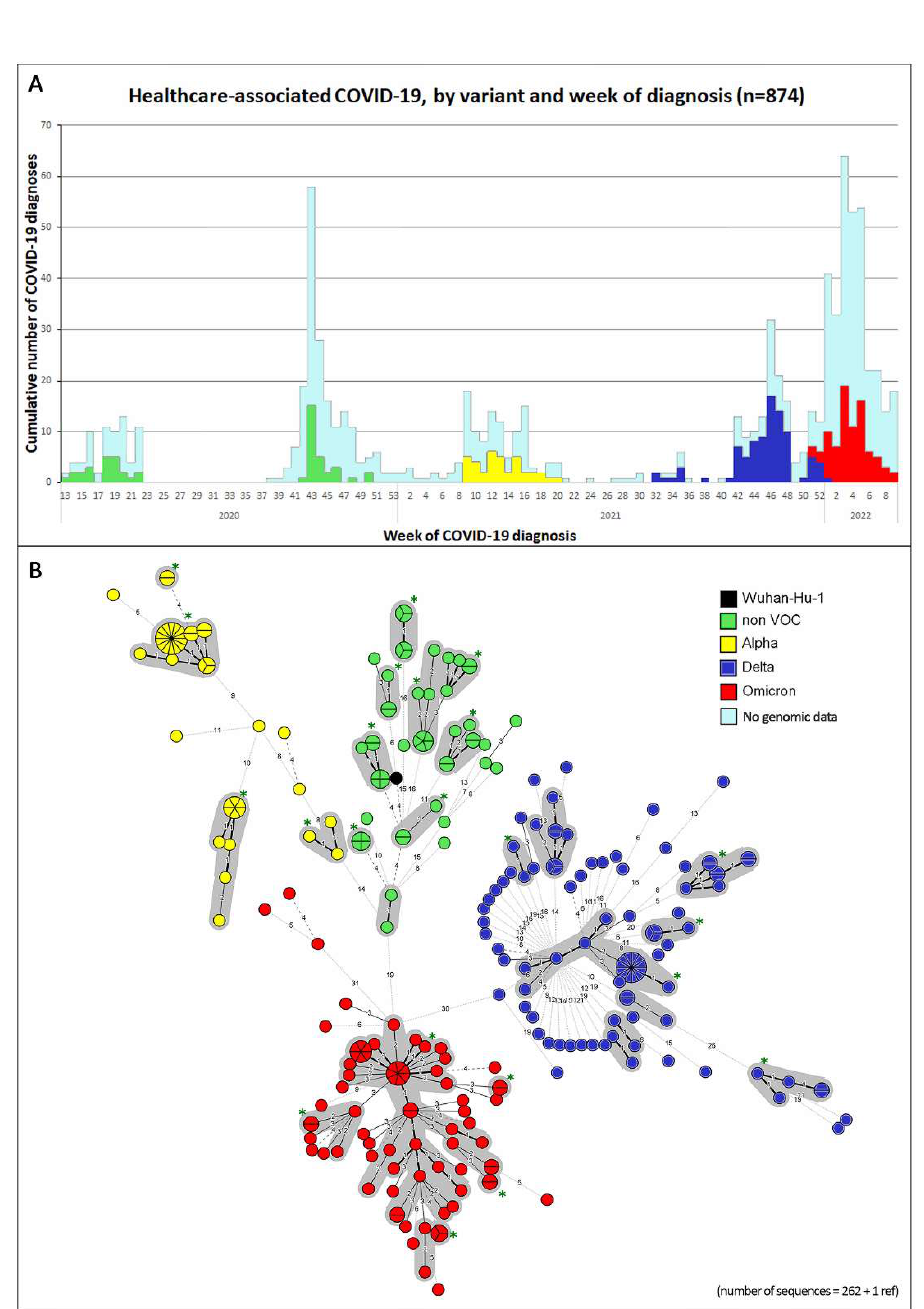
Figure 2. Epicurve and MST of healthcare-associated COVID-19 infections by WHO SARS-CoV-2 class and week of diagnosis. ( A ) Epicurve of our cases showing all healthcare-associated COVID-19 infections (HAI and aHCW) with SARS-CoV-2 WHO classes by color. Patients from whom no genomic data were available are marked in light blue. ( B ) MST (minimal spanning tree) of SARS-CoV-2 genomes of the patients whose samples were available for sequencing. The black genome represents the reference genome Wuhan-Hu-1 [18]. The size of the circles is proportional to the number of cases. Genomes that differed by ≤2 SNPs were clustered using the grey contours (HAI and aHCW together). Green asterisks are used to show the 22 clusters that contained at least 1 HAI case.